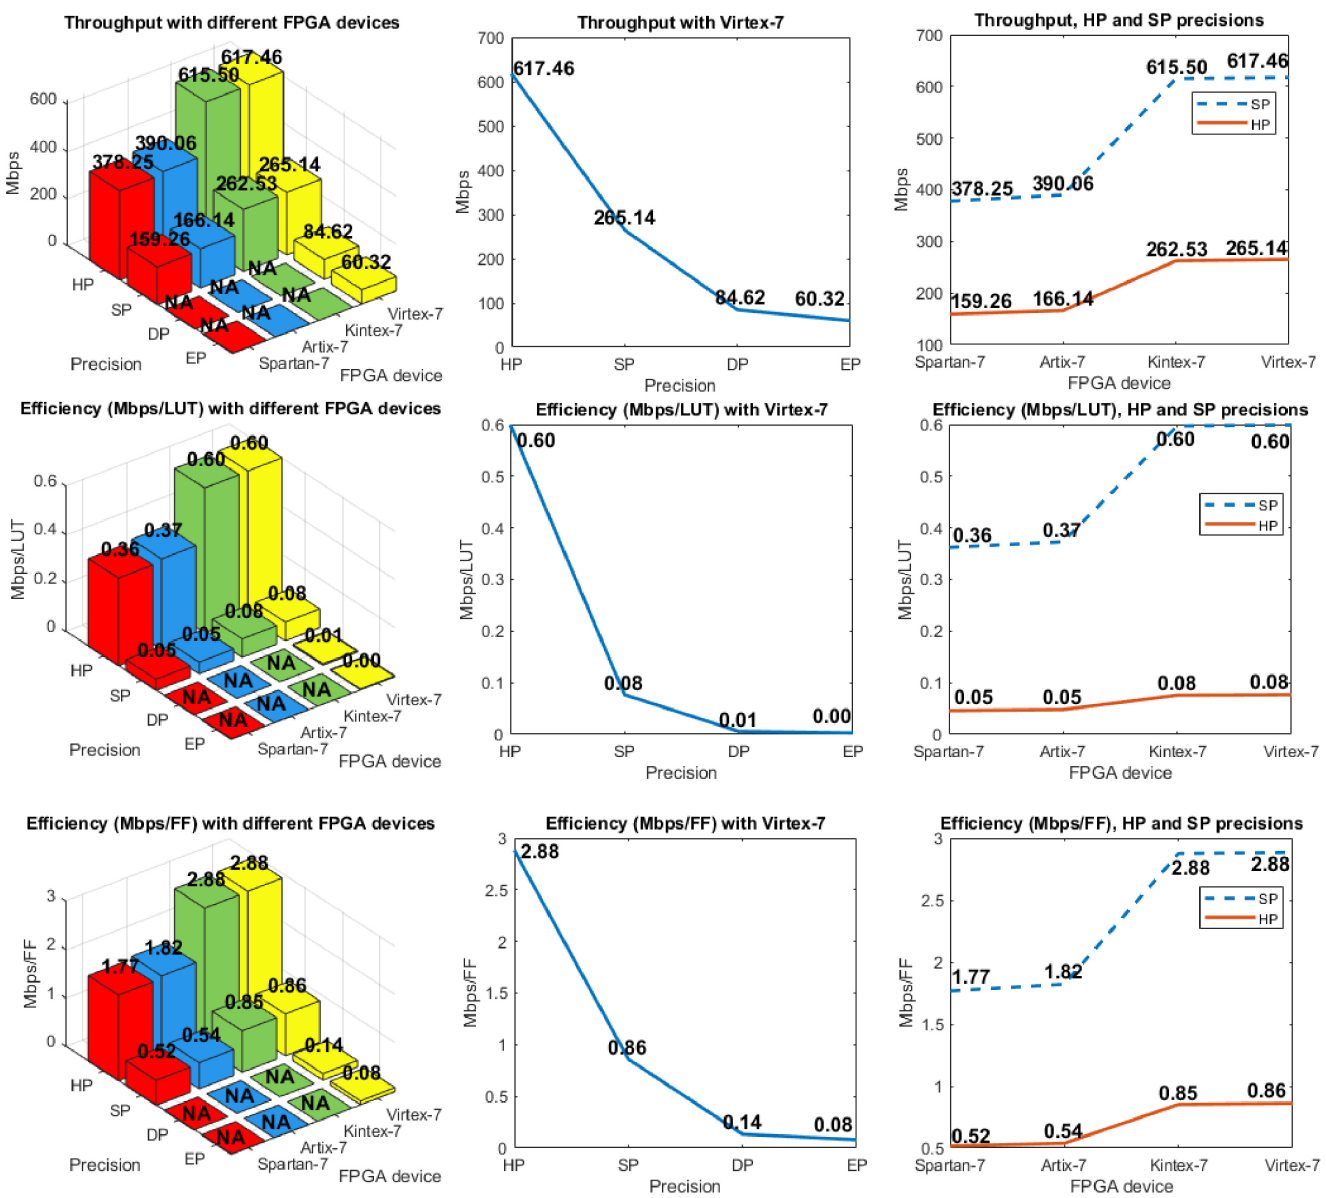
Fig 7. Throughput and efficiency (Mbps/LUT and Mbps/FF, respectively). (left) Different FPGA devices and precision levels; (center) Virtex-7 with different precision levels; (right) comparison of precision in the HP and SP designs with using different FPGAs. Throughput and efficiency were computed using Eqs (10) and (11),